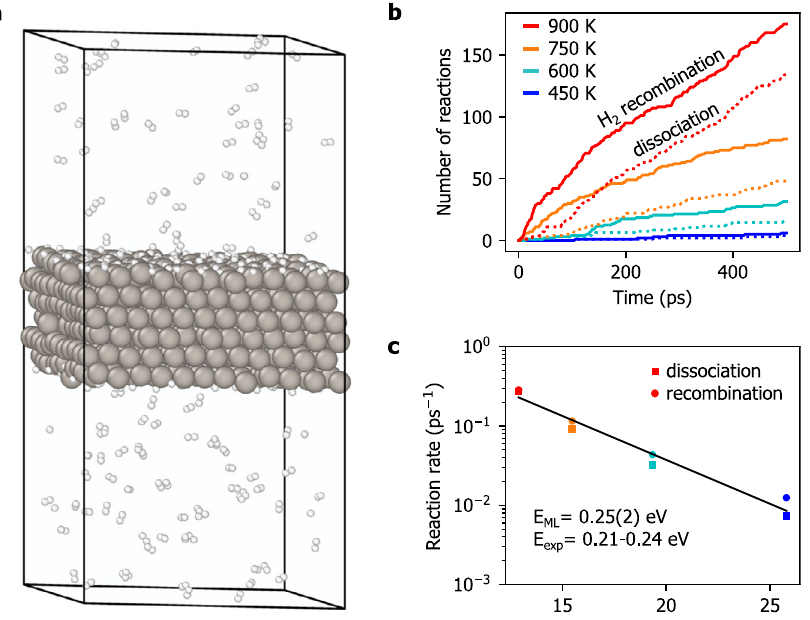
Fig. 4 | Reactive MD simulation of H/Pt(111) with the mapped SGP force fi eld. a Snapshot from a 500ps simulation at900K.The system isa six-layer slab model of a 12×12unitcellof Pt(111) with H 2 reactive events occurring at both sides of the slab. b Cumulative number of dissociation and recombination events observed at 450K(darkblue),600K(lightblue),750K(orange),and 900K(red).The reaction